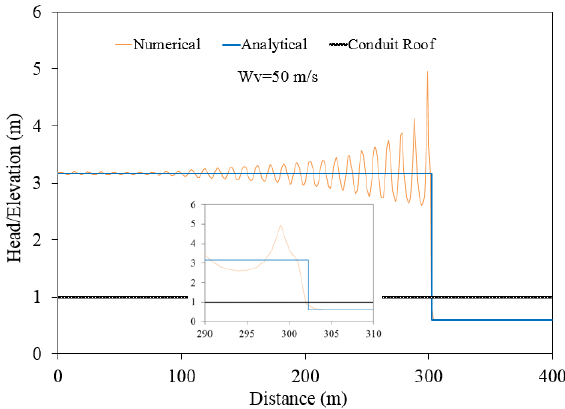
Figure 3. The numerical results at 10 s after the water level had risen in a test reservoir with an acoustic speed of 50 m/s (conventional HLL solver).